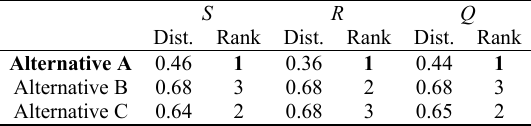
Table 9. Ranking of alternatives R Q Dist. Rank Dist. Rank Dist. Rank